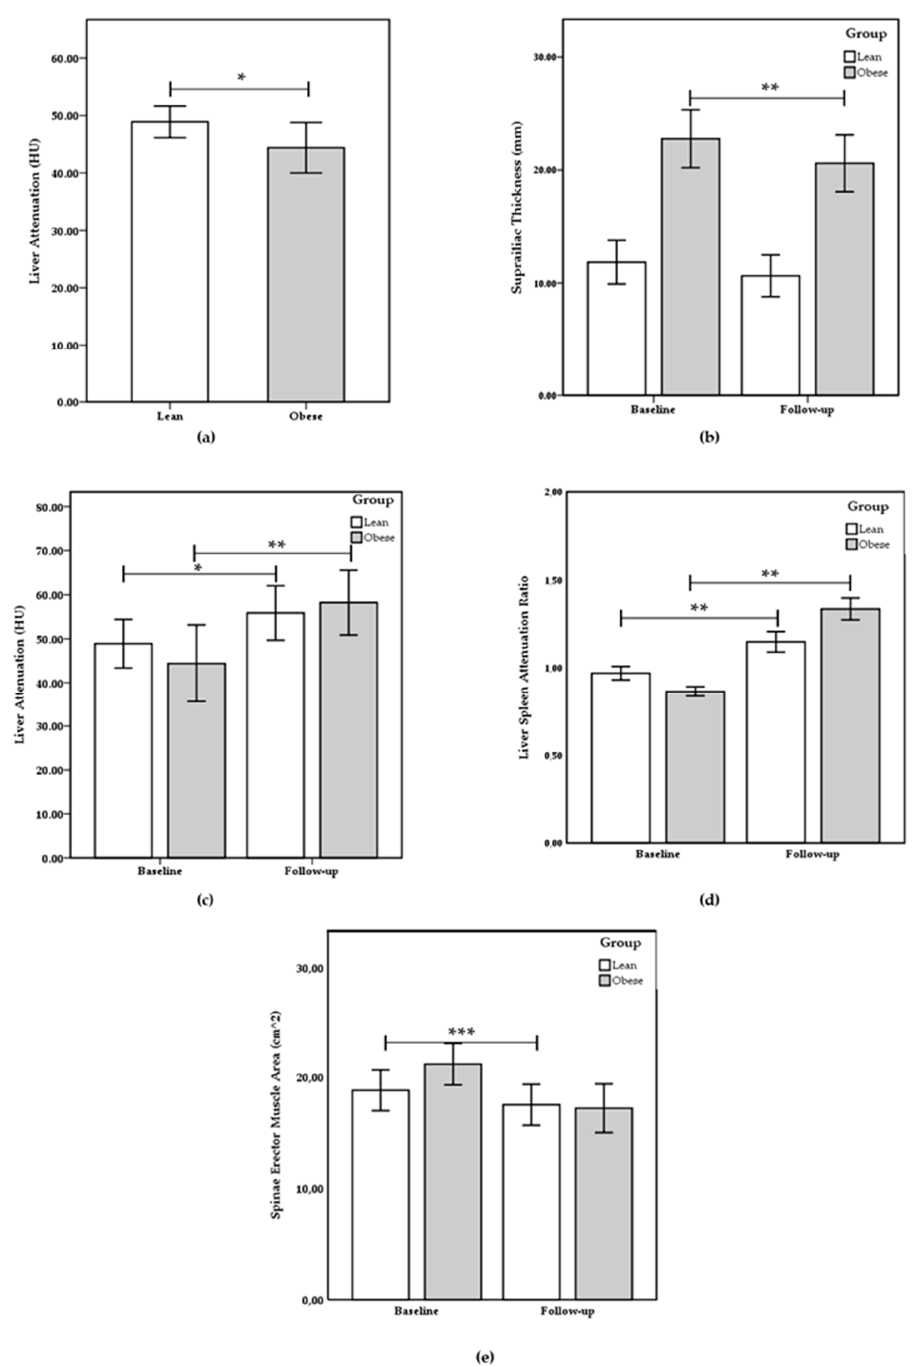
Figure 1. ( a ) Liver attenuation between lean and obese groups at baseline; between baseline and follow up, comparisons for ( b ) suprailiac thickness, ( c ) liver attenuation, ( d ) liver / spleen attenuation ratio, and ( e ) spinae erector muscle cross sectional area are shown. Values are presented as mean ± standard deviation. The statistical significance attributed to results with * p < 0.05, ** p < 0.005, and *** p < 0.001. Table 1. Descriptive and Compared between groups at baseline.